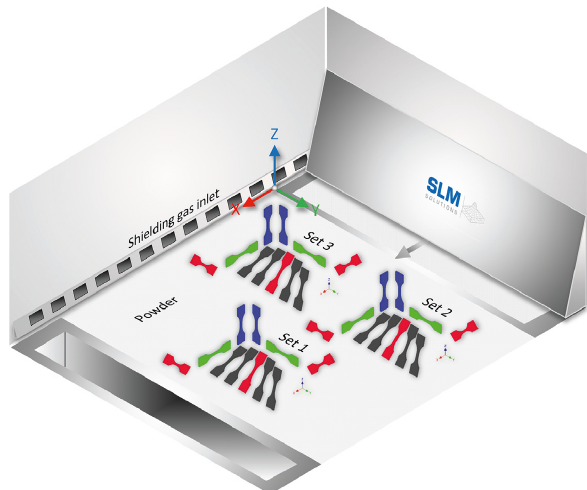
Figure 4: Orientation of the specimens and their configuration in the LPBF build platform. The colours indicate the samples that are used for determining the elastic constants in Section 2.3. Orien- tations are according to Table 3.